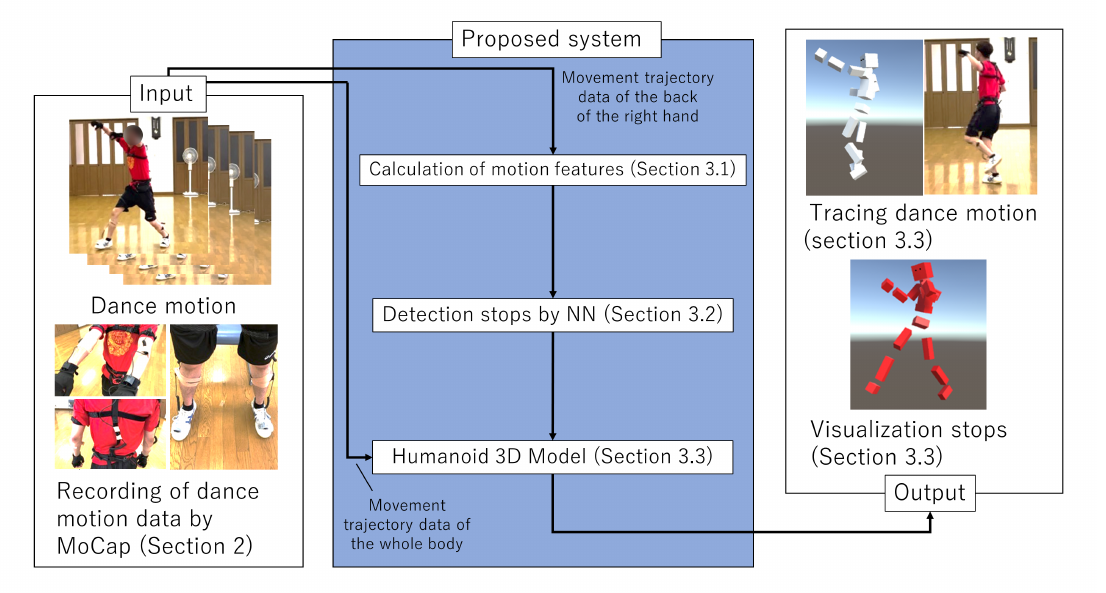
Figure 2. Overview of the proposed system. The dance motion data are recorded by MoCap (Section 2). The proposed system consists of three phases (Section 3). First, the motion features based on velocity and acceleration are calculated (Section 3.1). Stops are detected by a neural network model (Section 3.2). Stops are visualized using a humanoid 3D model via virtual reality spaces (Section